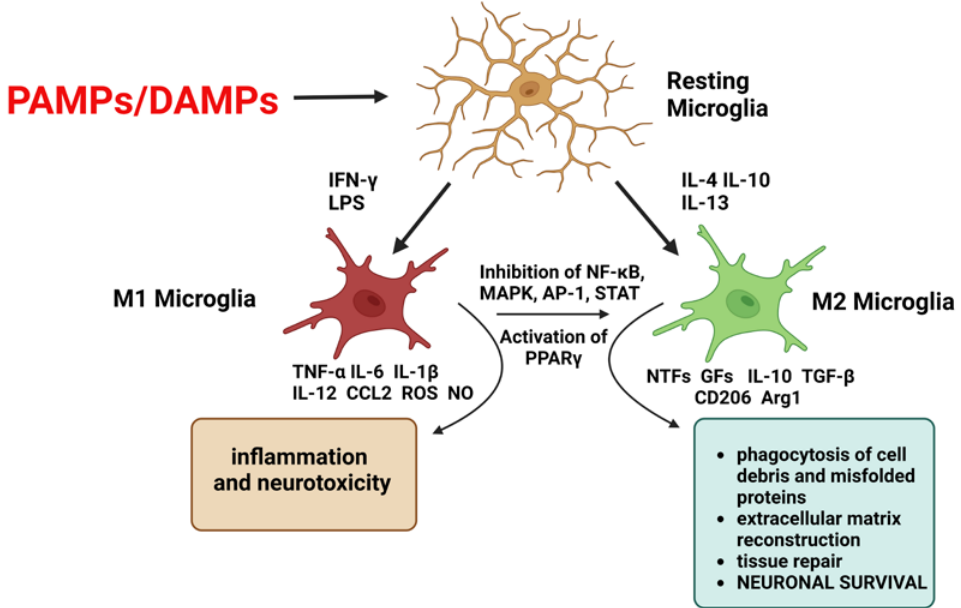
Figure 1. Microglia are activated by pathogen-associated molecular pattern molecules (PAMPs) and/or damage-associated molecular pattern molecules (DAMPs). The classical M1 activation can be induced by interferon- γ (IFN- γ ) and lipopolysaccharide (LPS). M1 microglia produce inflammatory cytokines and chemokines, such as tumor necrosis factor-alpha (TNF- α ), interleukin (IL)-6, IL-1 β , IL-12, and CC chemokine ligand (CCL) 2, and induce inflammation and neurotoxicity. The alternative M2 activation is induced by anti-inflammatory cytokines such as IL-4, IL-13, and IL-10. M2 microglia release growth factors (GFs), and neurotrophic factors (NTFs), induce mannose receptor (CD206) and arginase 1 (Arg1), and promote neuronal survival. Shifting from M1 to M2 phenotype may occur via inhibition of nuclear factor kappa-light-chain-enhancer of activated B cells (NF- κ B), mitogen-activated protein kinase (MAPK), activator protein 1 (AP-1), and signal transducer and activator of transcription (STAT) transcription factors, and activation of the peroxisome proliferator-activated receptor gamma (PPAR γ ) pathway. The figure was created with BioRender.com.